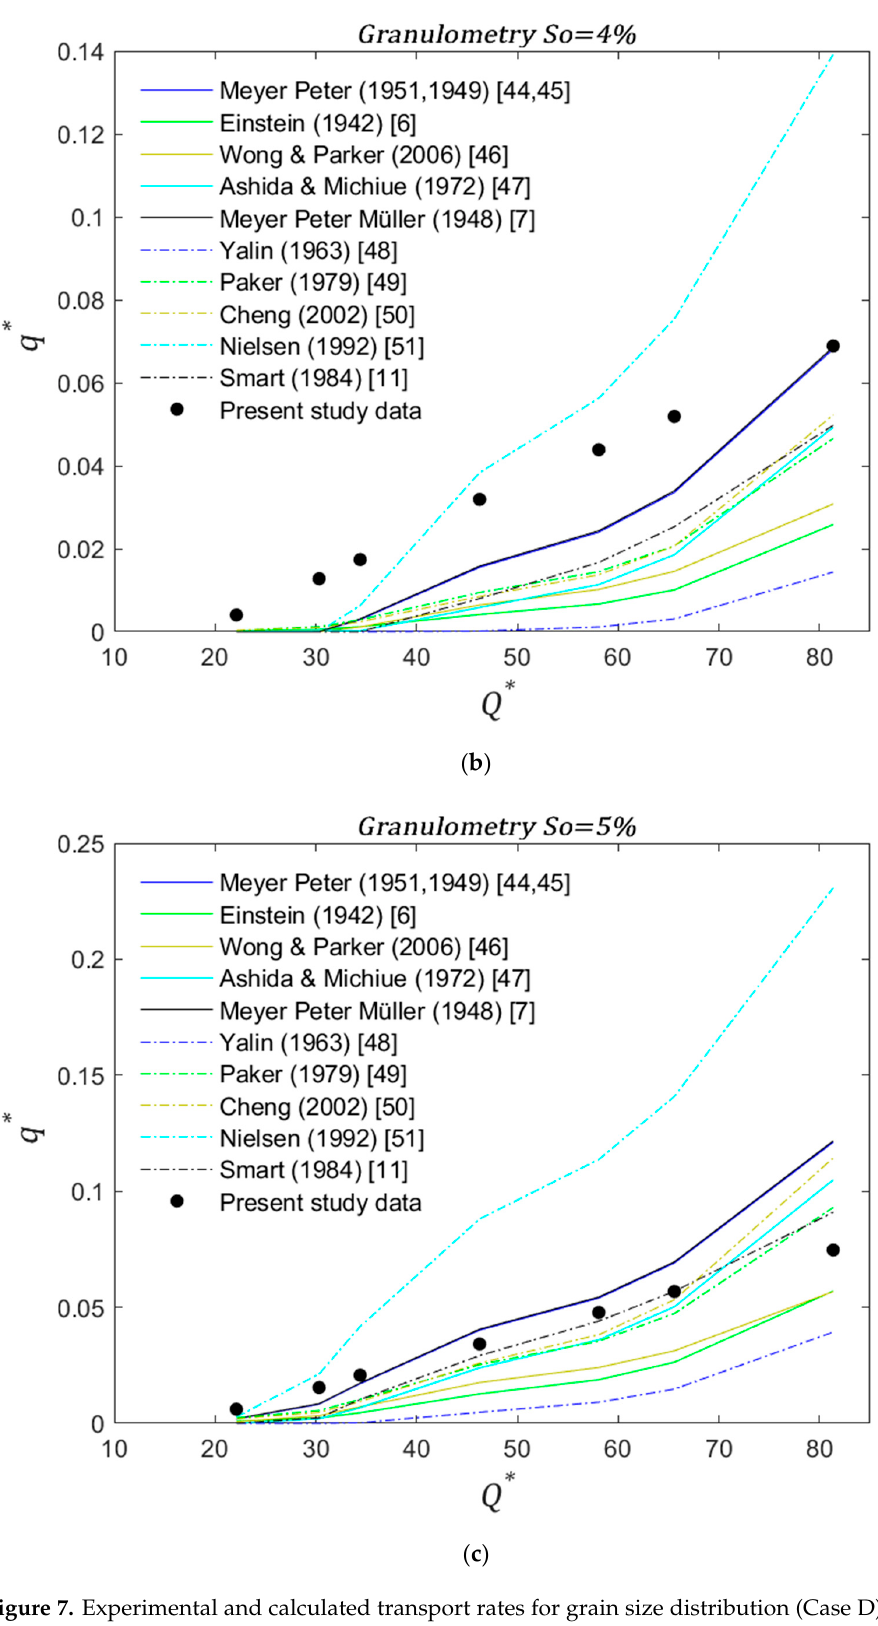
Figure 7. Experimental and calculated transport rates for grain size distribution (Case D) with ( a ) So =3%, ( b ) So =4%, and ( c ) So =5%.